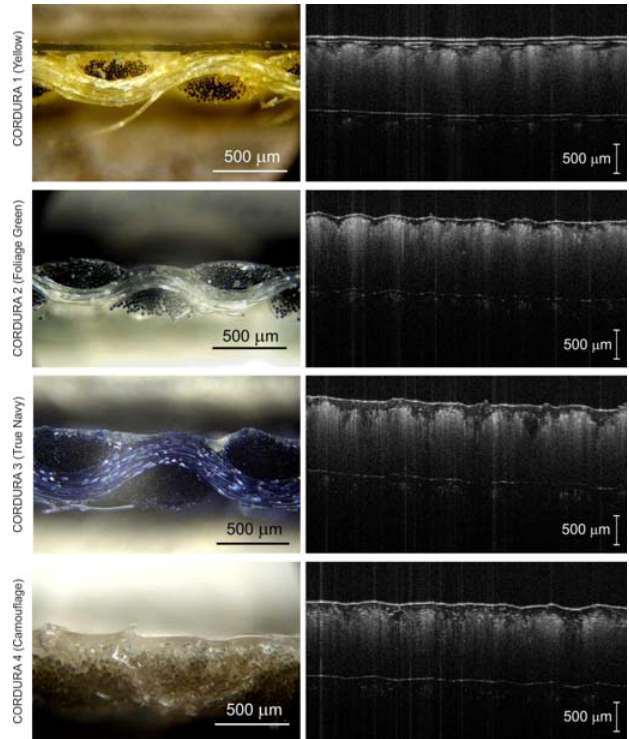
Figure 5. Cross-section images of Cordura materials made using Neophot 21 dark-field microscope with an objective magnification of × 80 or × 100 (left column); and corresponding OCT B -scans of the same Cordura samples obtained with Spark OCT-1300 system (right column).